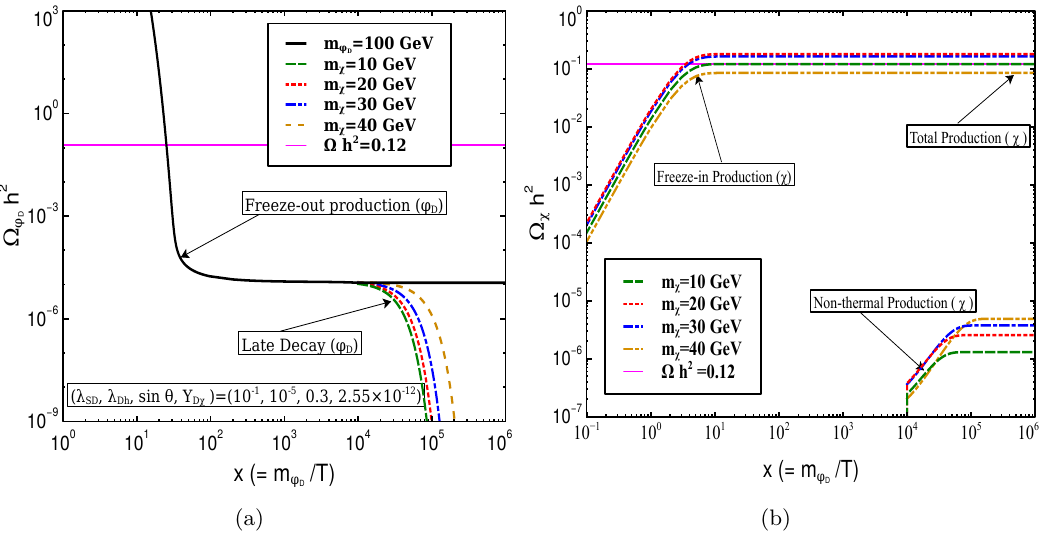
Figure 8 . Left panel: figure 8(a) shows the variation of Ω φ shows the variation of Ω 2 w.r.t. x . This corresponds to the freeze-in dominated χ h